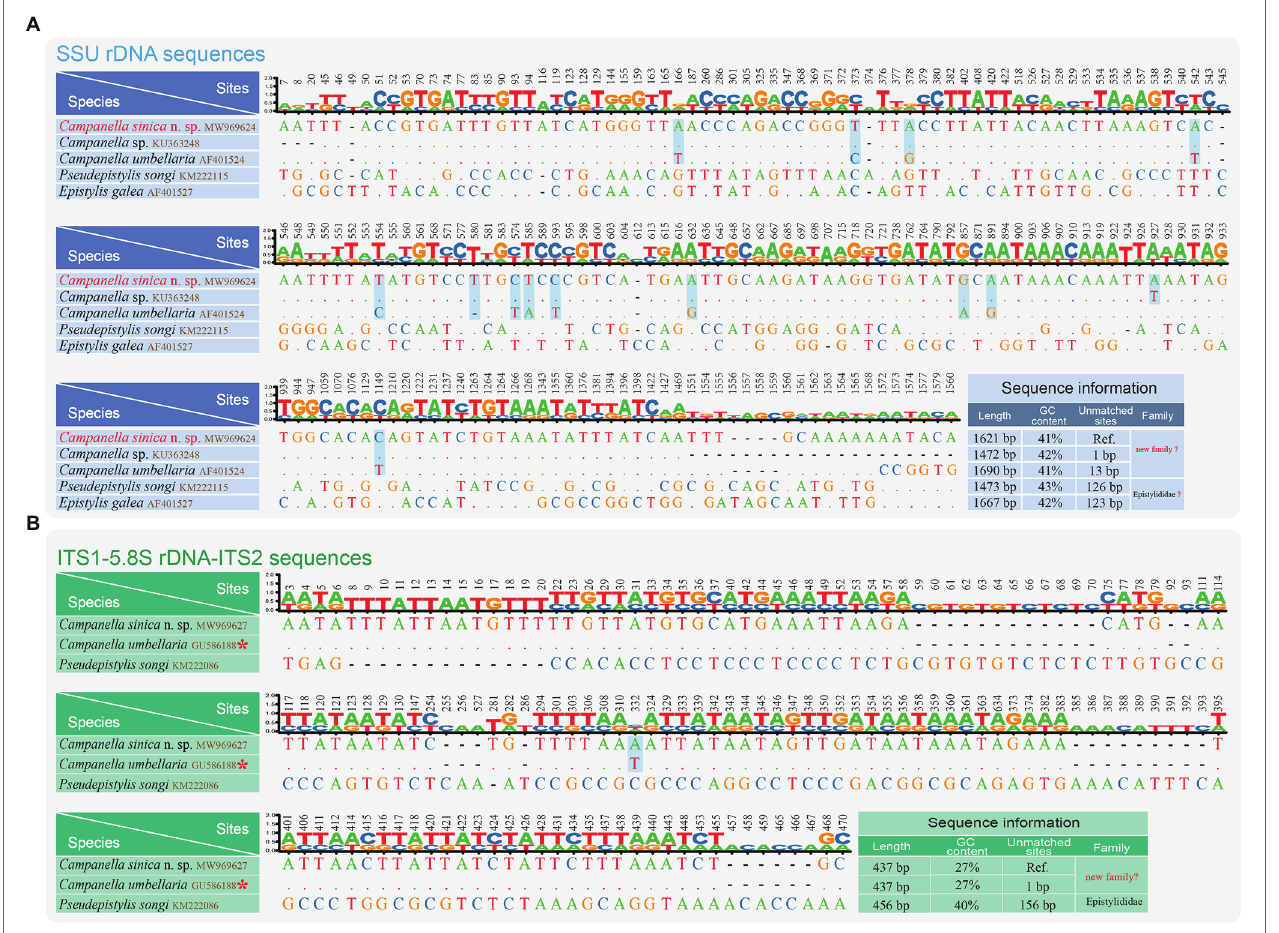
FIGURE 3 | Nucleotide differences among Campanella sinica n. sp. and closely related taxa based on SSU rDNA sequences (A) and ITS1-5.8S rDNA-ITS2 sequences (B) . The numbers in the header indicate the unmatched site positions. The sequences of Campanella sinica n. sp. in this study are shown in red. The variable sites of C. sinica n. sp. and the other Campanella species are shown in gray. Ref., reference sequence. The asterisk indicates the validity of this sequence needs to be